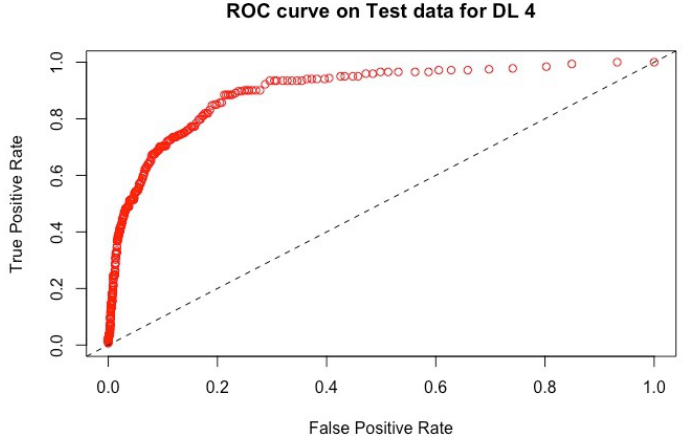
Figure 4. ROC curve for the model D4 using 181 variables with the test